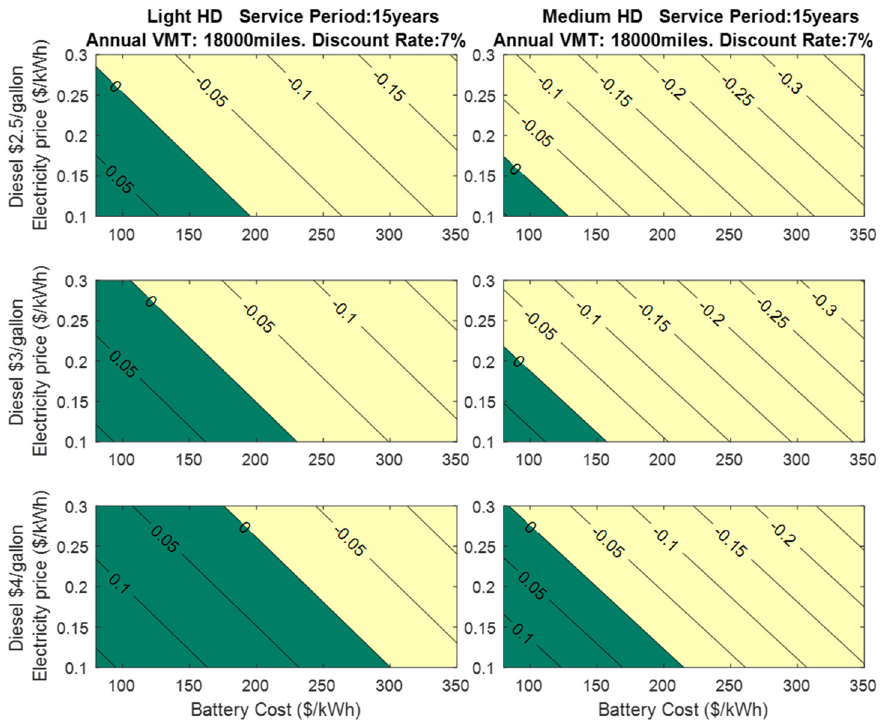
Figure 2. Purchase price parity comparison of all vehicles considered in this study.